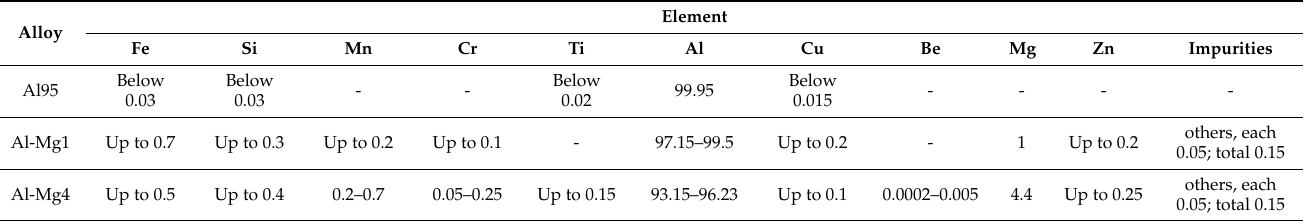
Table 2. Chemical composition of the studied